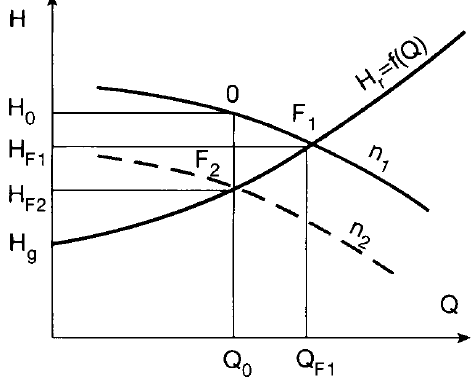
Figure 1. Flow rate adjustment using pump speed control.